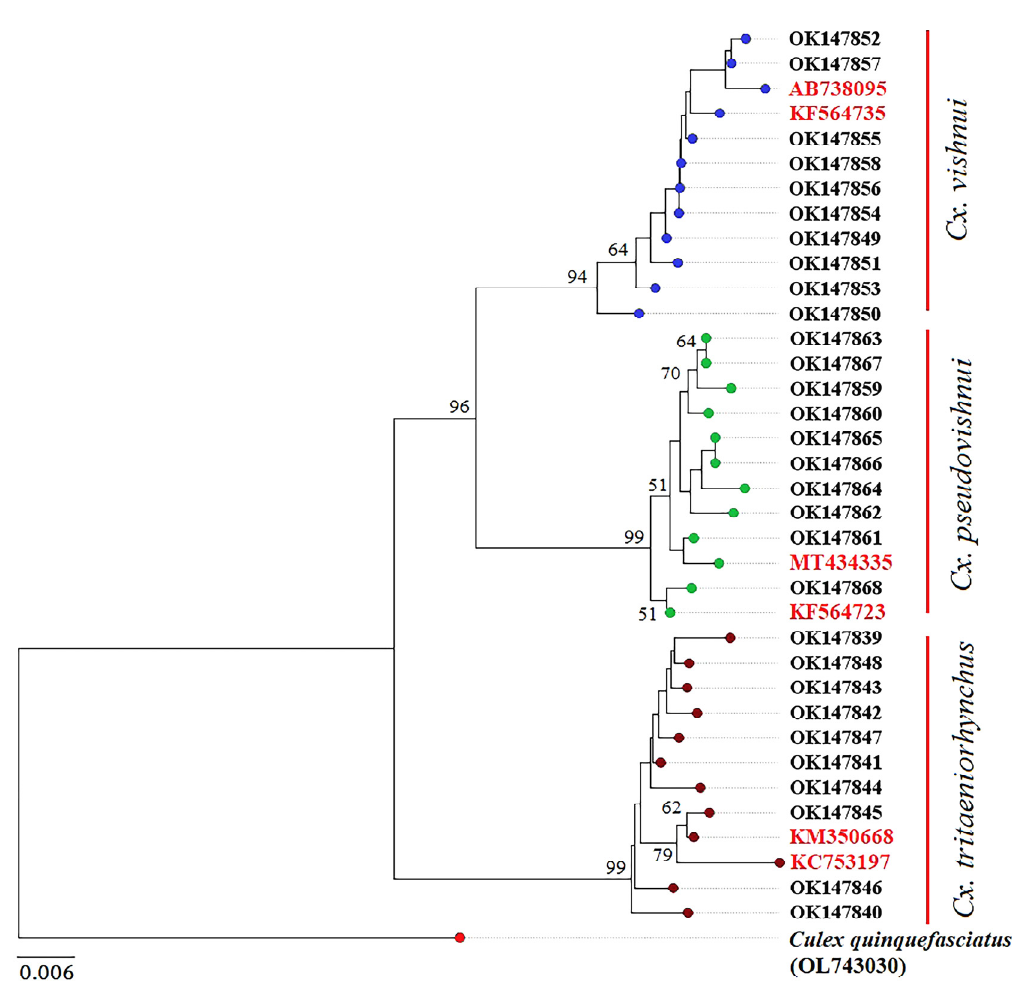
Figure 8. Neighbor-joining tree showing the phylogenetic relationships between Cx. pseudovishnui , Cx. tritaeniorhynchus , and Cx. vishnui . The COI sequences generated in this study are black (n = 30), while those from GenBank are red (n = 6). The Cx. quinquefasciatus sequence from GenBank (OL743030) was used as an outgroup. Only bootstrap values ≥ 50% are shown. The result of species delimitation by the ASAP method is indicated by vertical red bars.